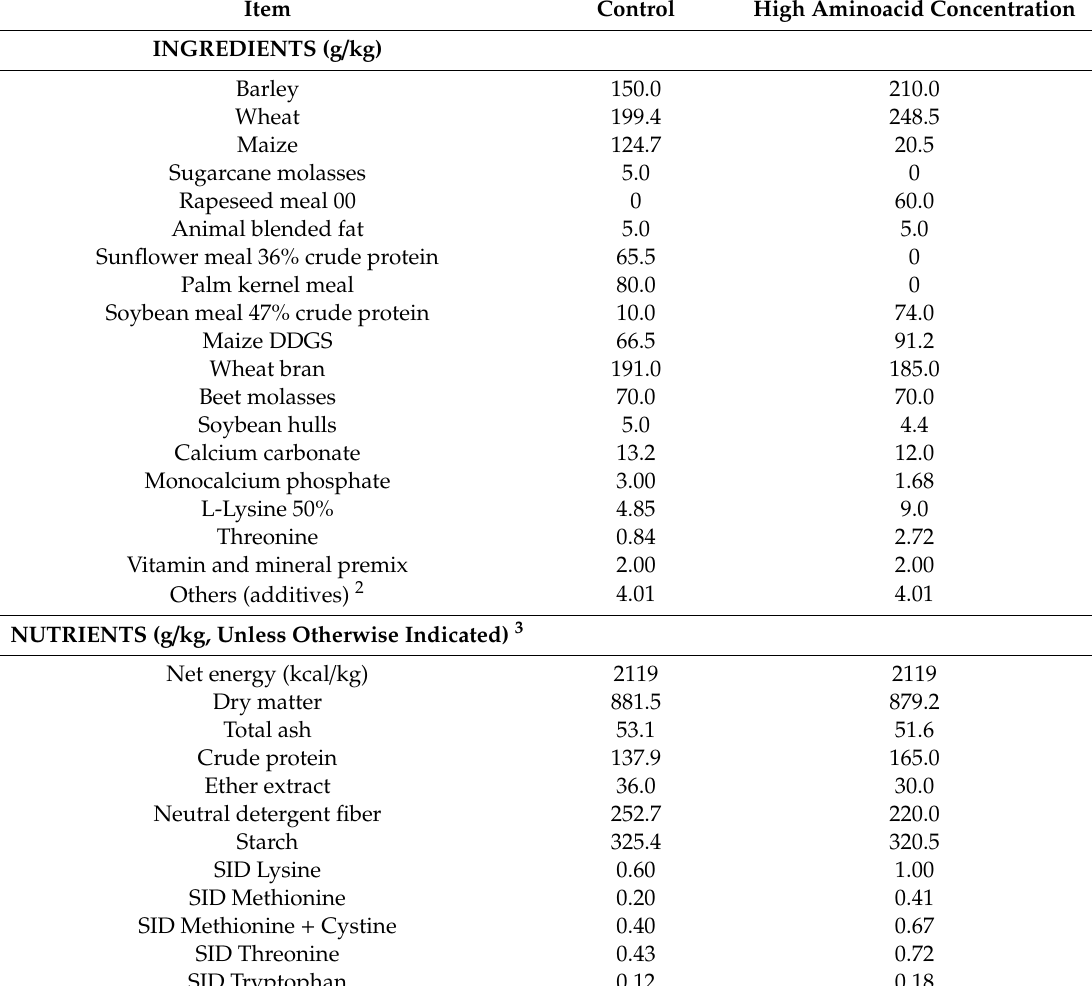
Table 1. Composition of the diets tested from day 77 to 107 of gestation in hyperprolific multiparous sows (as-fed